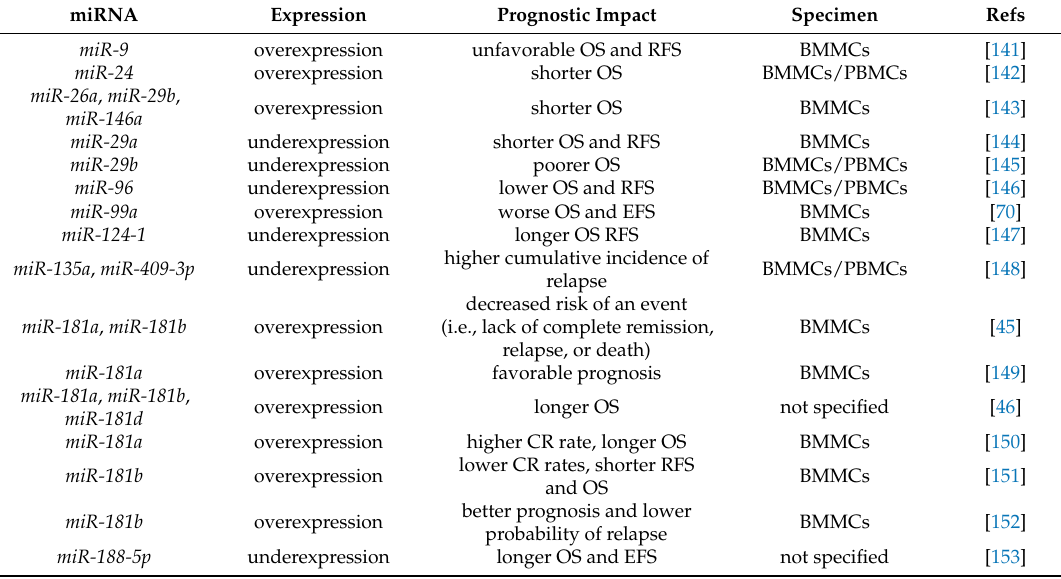
Table 4. miRNAs as prognostic biomarkers in